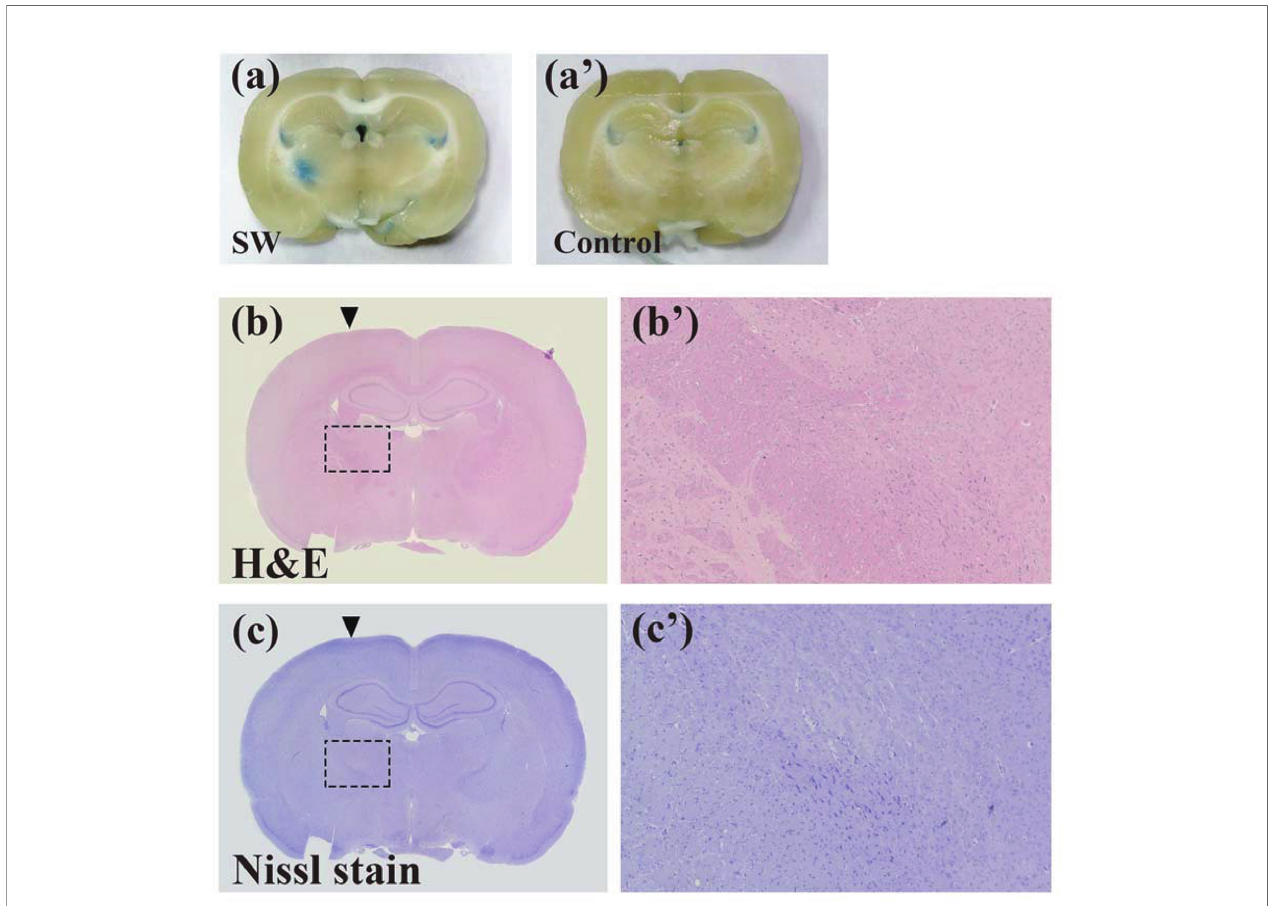
FIGURE 2 | SW treatments inducing the blood-brain barrier (BBB) opening did not damage brain tissue. The BBB opening was evaluated using Evans blue extravasation ( A and a ’ ). Brain damage in rats with or without SW treatment was assessed using H&E staining ( B and b ’ ) and Nissl staining ( C and c ’ ). SW,